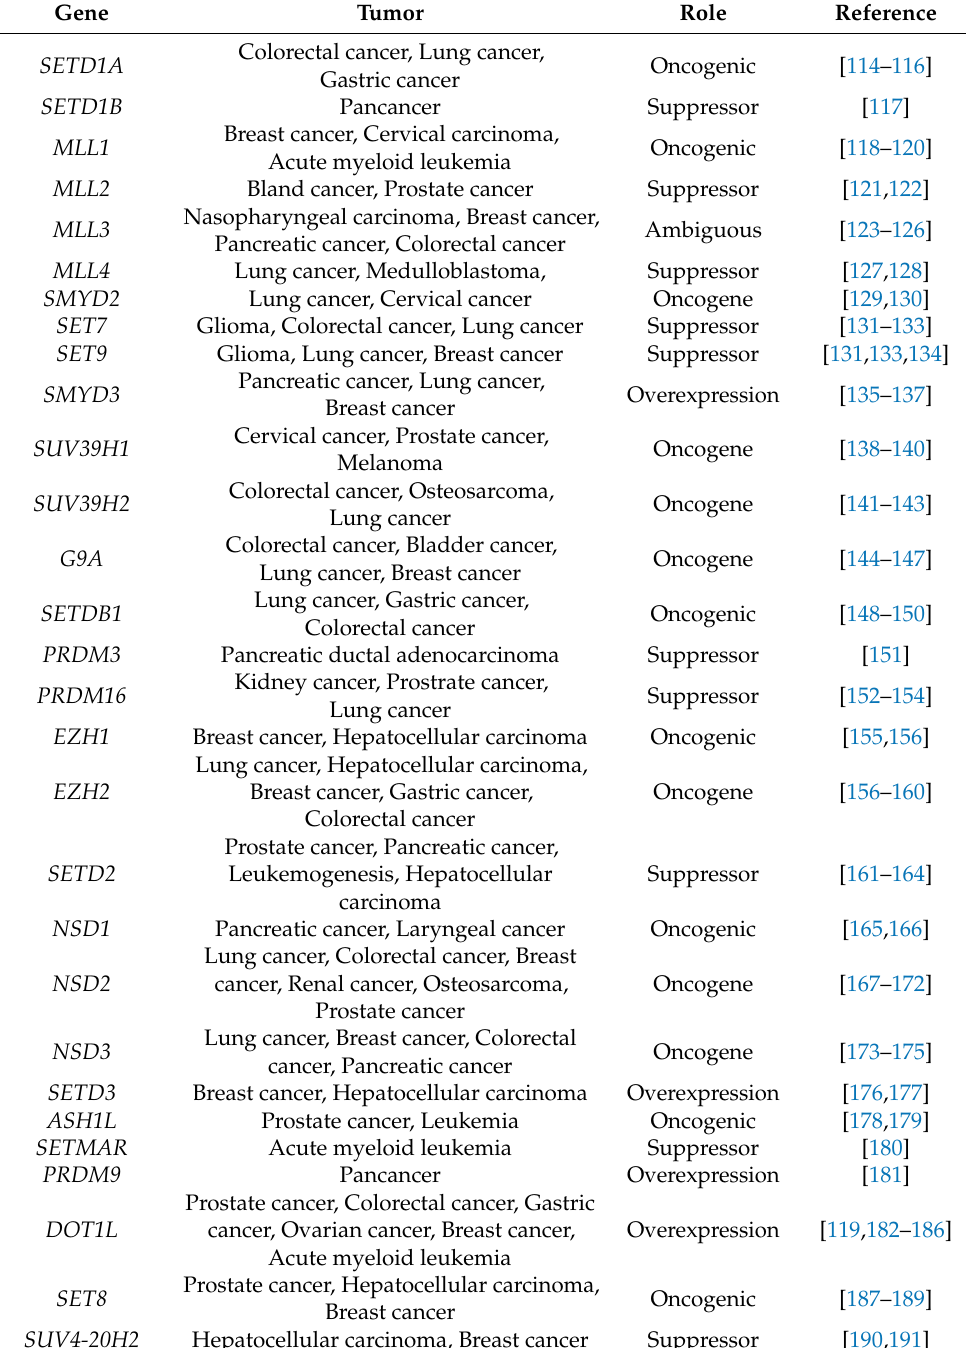
Table 1. The role of genes encoding histone methyltransferase in human